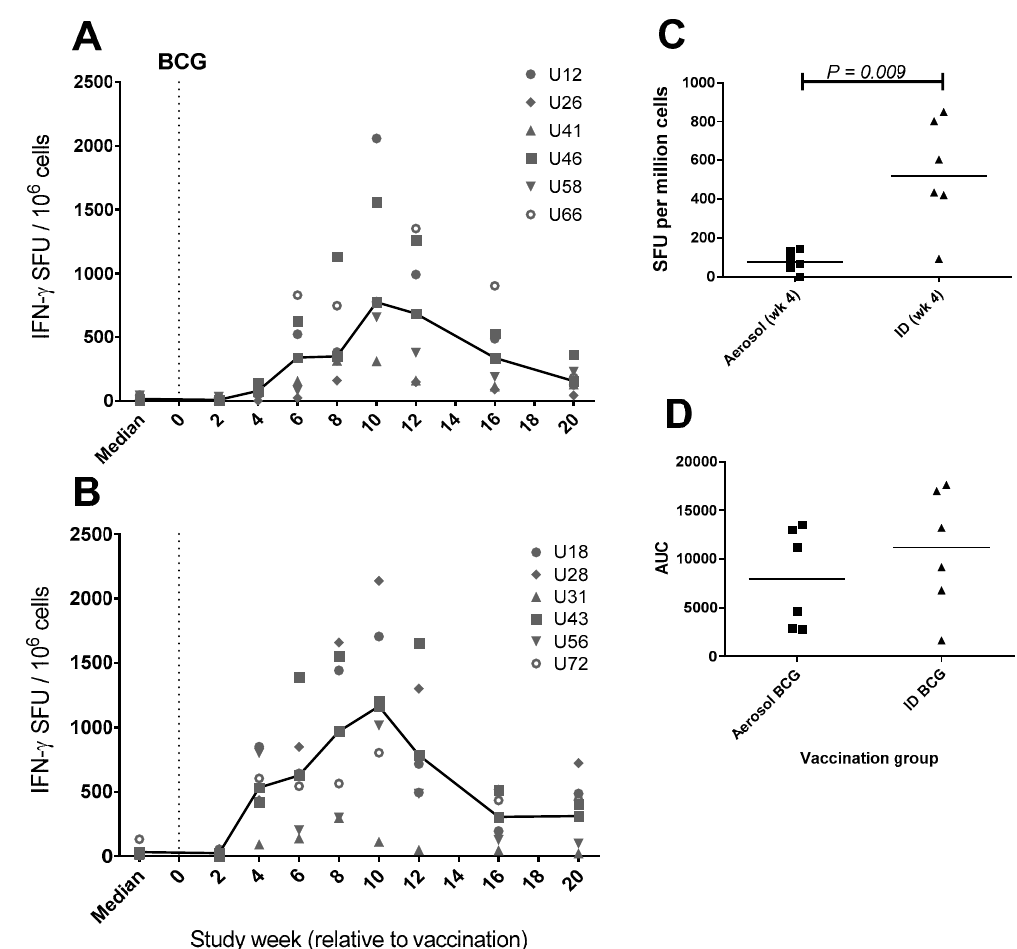
Figure 7. Systemic purified protein derivative (PPD)-specific IFN- γ spot forming unit (SFU) frequency measured by ELISpot assay following aerosol or ID Bacille Calmette-Guérin (BCG) vaccination. PPD-specific IFN- γ SFU measured in individual aerosol ( A ) or ID ( B ) BCG-vaccinated animals are shown as points with vaccination group median line. Vaccination with aerosol or intradermal BCG is indicated by a dotted line at study week zero. Pre-vaccination SFU frequency is shown as the median of at least 3 replicate values for each animal. Plot C shows a dot plot comparison of IFN- γ SFU frequency four weeks after vaccination, and plot D shows area under the curve (AUC) values calculated from each animal’s SFU frequency profile between weeks 0–20. The group median is indicated by horizontal lines and Mann–Whitney U-test significance values are